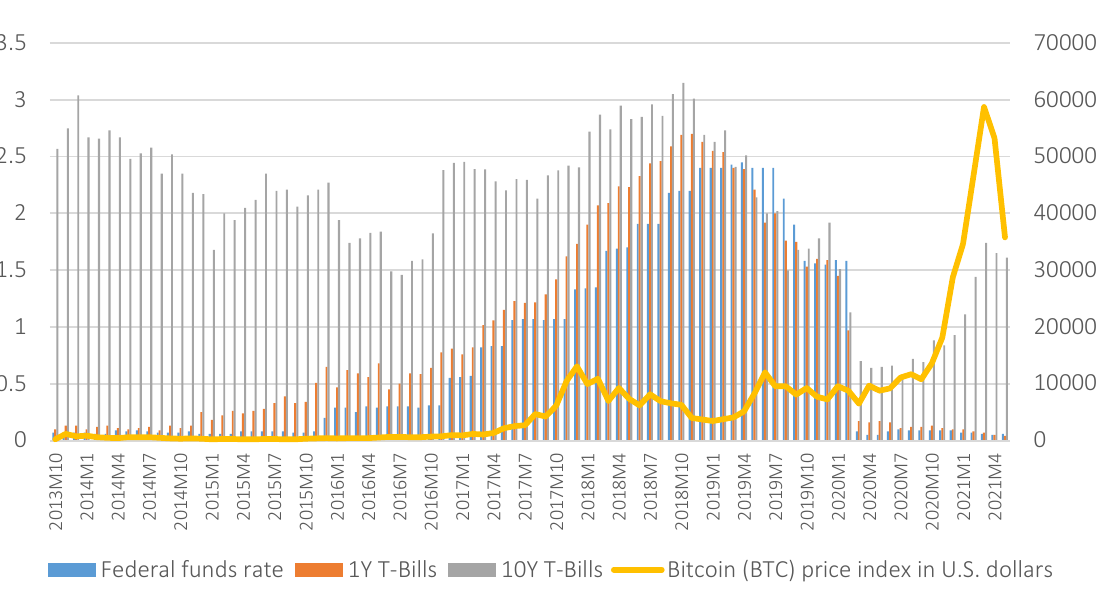
Figure 2. Bitcoin and US interest